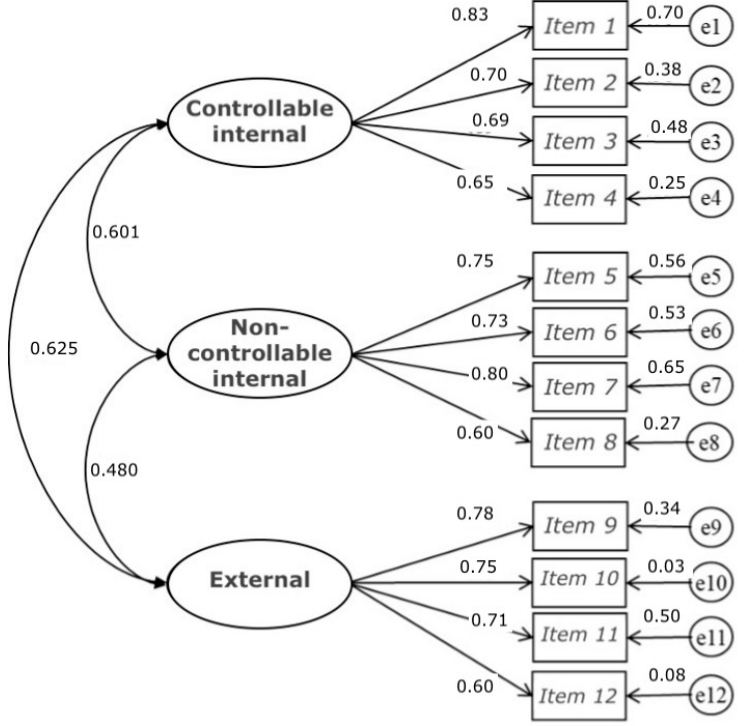
Figure 1. Model of three related factors of the Scale of Attributions of Academic Success .